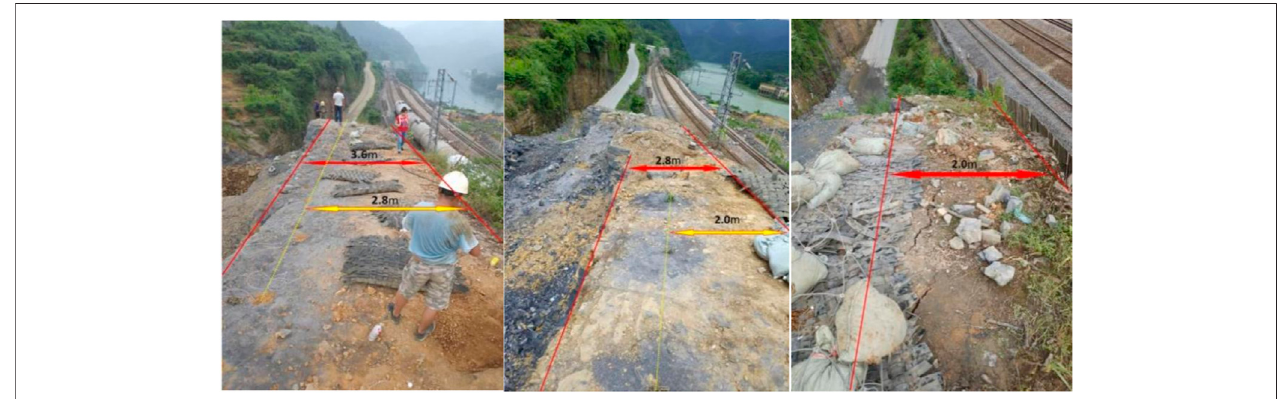
FIGURE 14 | Distance between free face and back of rock wall after each